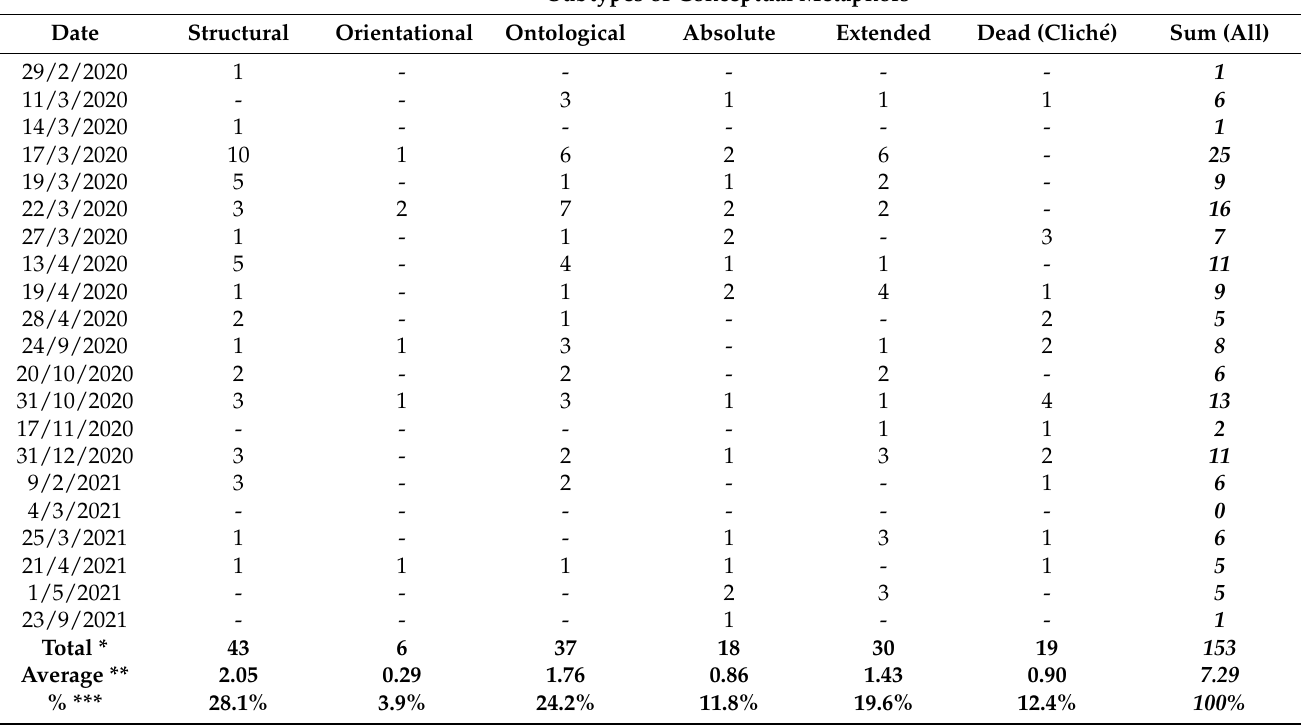
Table 1. Utilization of Metaphors by the Greek PM in Public Addresses during the COVID-19 Crisis: Analysis per Subtype, based on the Conceptual Metaphors